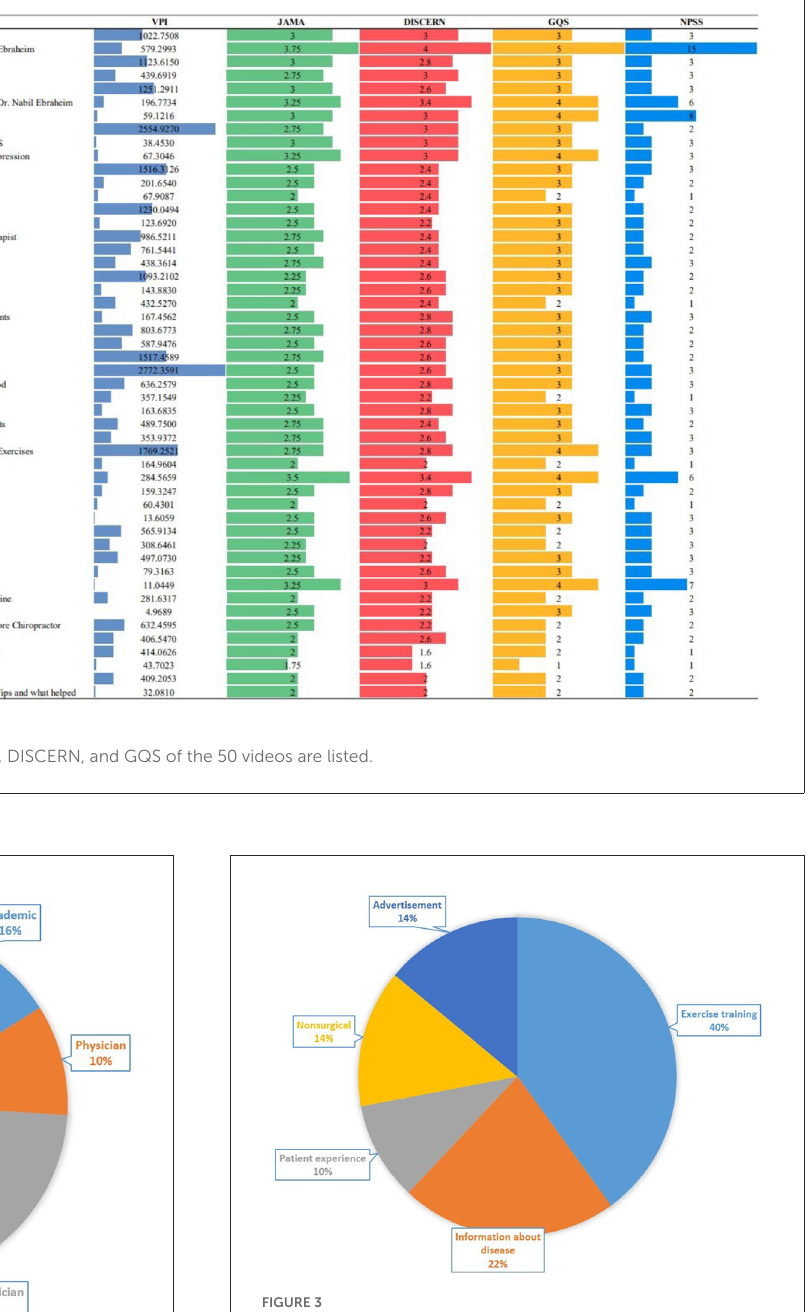
Additionally, between-group effects were calculated according to their upload source and contents. Significant differences between the uploading sources were observed for VPI ( P = 0.012), JAMA ( P < 0.0001), DISCERN ( P < 0.0001),